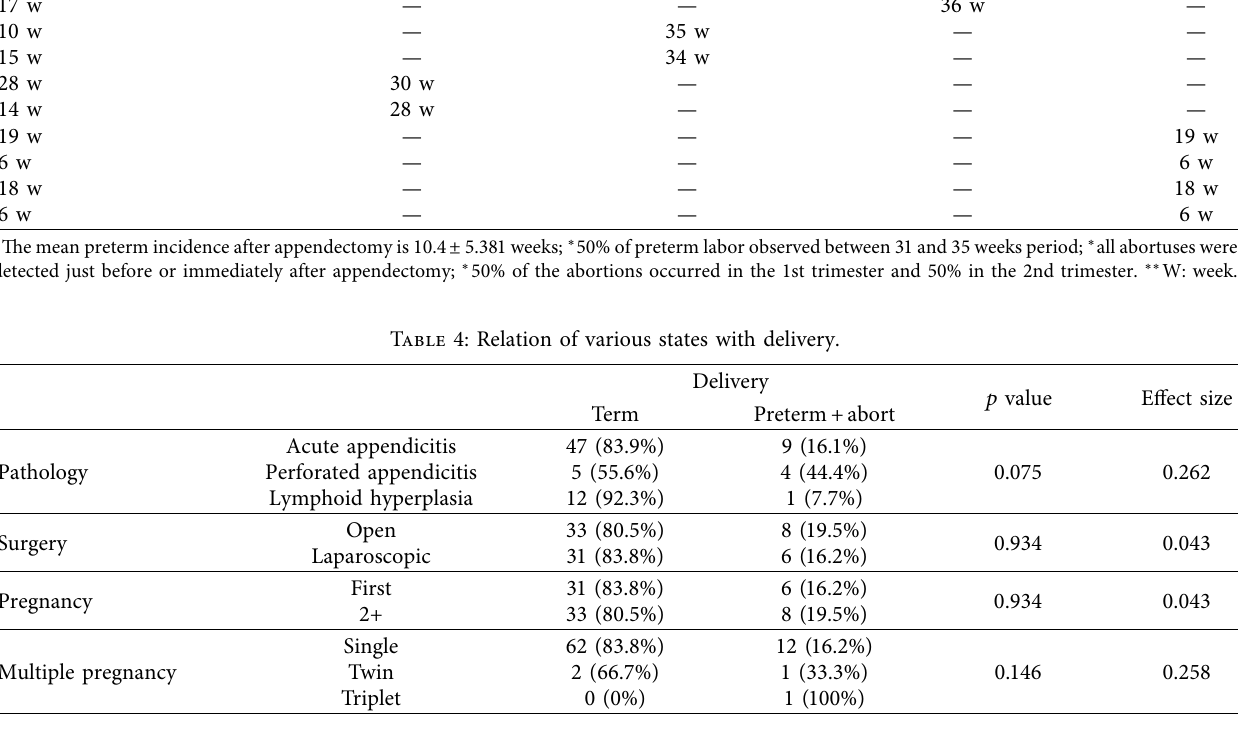
Table 5: Effects of WBC and CRP on delivery.